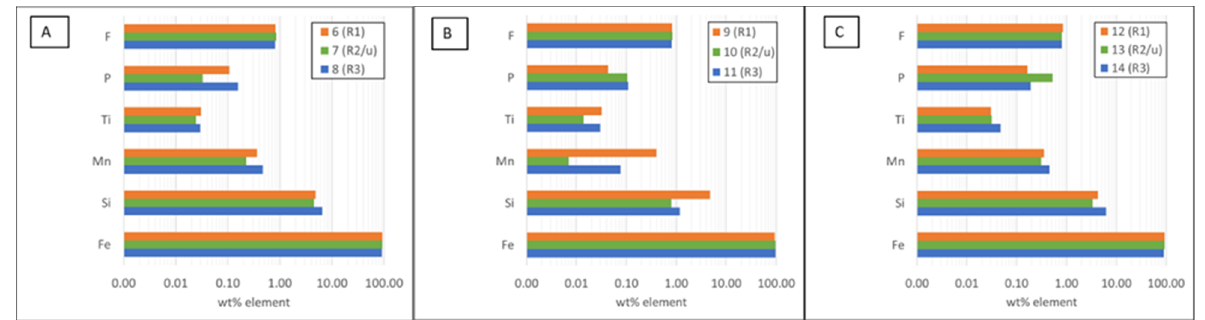
Figure 8. Average ferrite compositions in wt% determined by EPMA in experiments on variously doped concentrates R1, R2/u, and R3. ( A ) 7% CaF 2 , ( B ) 5% CaO, and ( C ) 7% CaF 2 + 5% CaO additions.